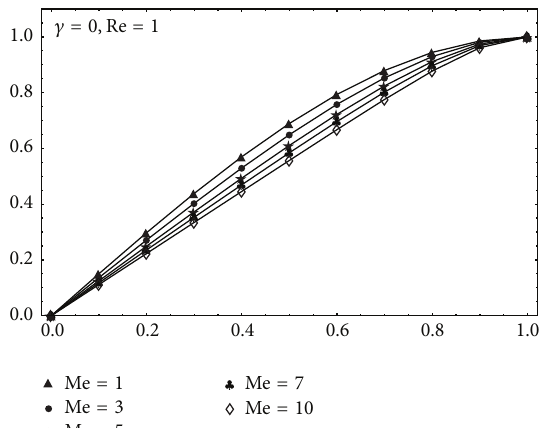
Figure 6: Velocity profile for different values of Hartmann number with Re = 1 and 𝛾 = 0 .